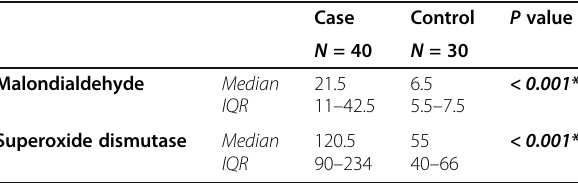
Table 3 Sputum cytology in the cases